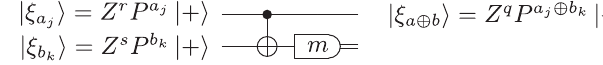
FIG. 3. Securely applying a P † b phase correction with aid of an appropriate ancilla. Since r is a random bit, Bob (represented by dashed box) remains ignorant of Alice ’ s key b .